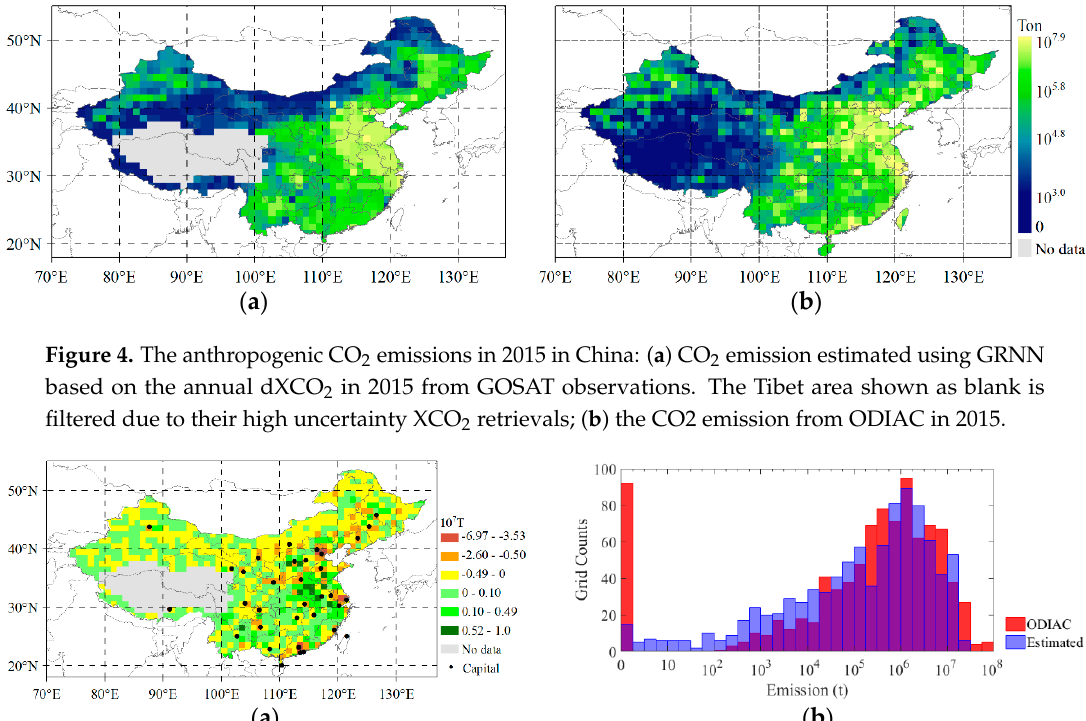
Figure 4. The anthropogenic CO 2 emissions in 2015 in China: ( a ) CO 2 emission estimated using GRNN based on the annual dXCO 2 in 2015 from GOSAT observations. The Tibet area shown as blank is filtered due to their high uncertainty XCO 2 retrievals; ( b ) the CO2 emission from ODIAC in 2015.